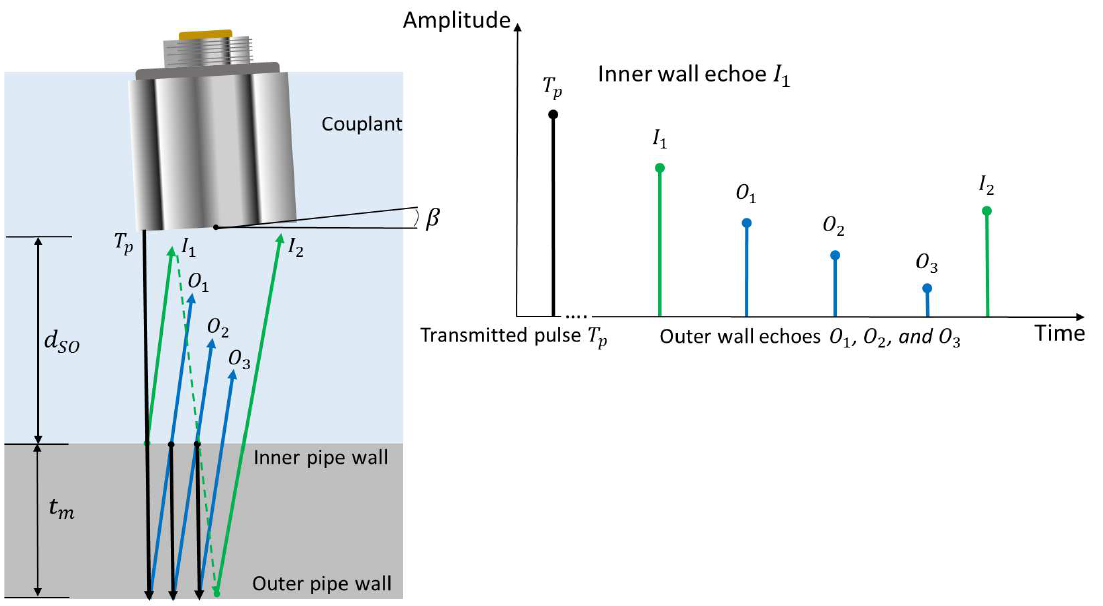
Figure 2. Physical parameters to ensure correct echo capture for the automatic pipeline